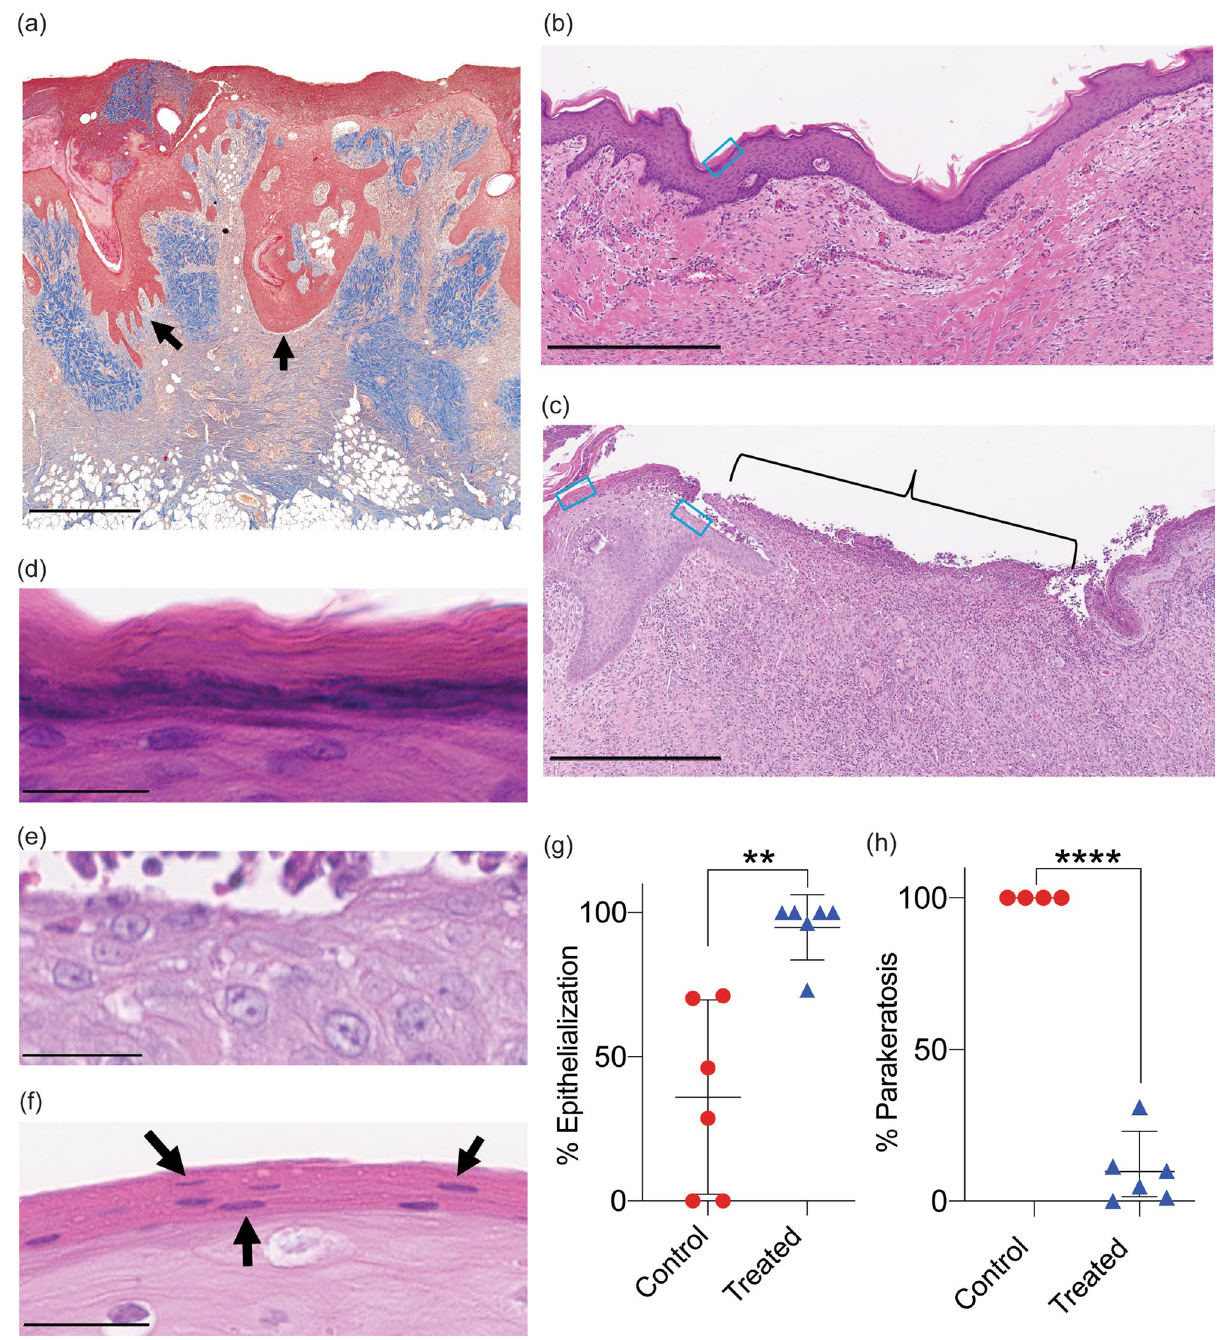
Figure 2. Histologic characterization of wound re-epithelialization. ( a ) Epidermal structures are preserved when using MSTCs to treat wounds. Representative Trichrome image of an MSTC-treated wound after 1 week. Epidermal segments appear to be migrating towards the wound surface, as highlighted by the arrows. Scale bar = 1 mm. ( b ) Representative H&E image of the center of an MSTC-treated wound 2 weeks after treatment, showing complete re-epithelialization. The blue box outlines an example region where the feature highlighted in ( d ) below can be found. Scale bar = 500 µm. ( c ) Representative H&E image of the center of control wounds at 2 weeks. Bracket highlights area without epithelium. The two blue boxes outline example regions where the features highlighted in ( e ) (right box) and ( f ). (left box) below can be found. Scale bar = 500 µm. ( d ) Representative image of the stratum corneum of MSTC-treated wounds, with the characteristic stratified, anuclear structure. Scale bar = 25 µm. ( e ) Representative image of the unepithelialized portion of control wounds. Scale bar = 25 µm. ( f ) H&E image showing parakeratosis (retention of nuclei in the stratum corneum) in epithelialized portions of control wounds. Scale bar = 25 µm. ( g ) Percentage epithelialization and parakeratosis in MSTC-treated (n = 6) and control wounds (n = 6) 2 weeks post wounding are shown in ( g ) and ( h ), respectively. **p ≤ 0.005, ****p ≤